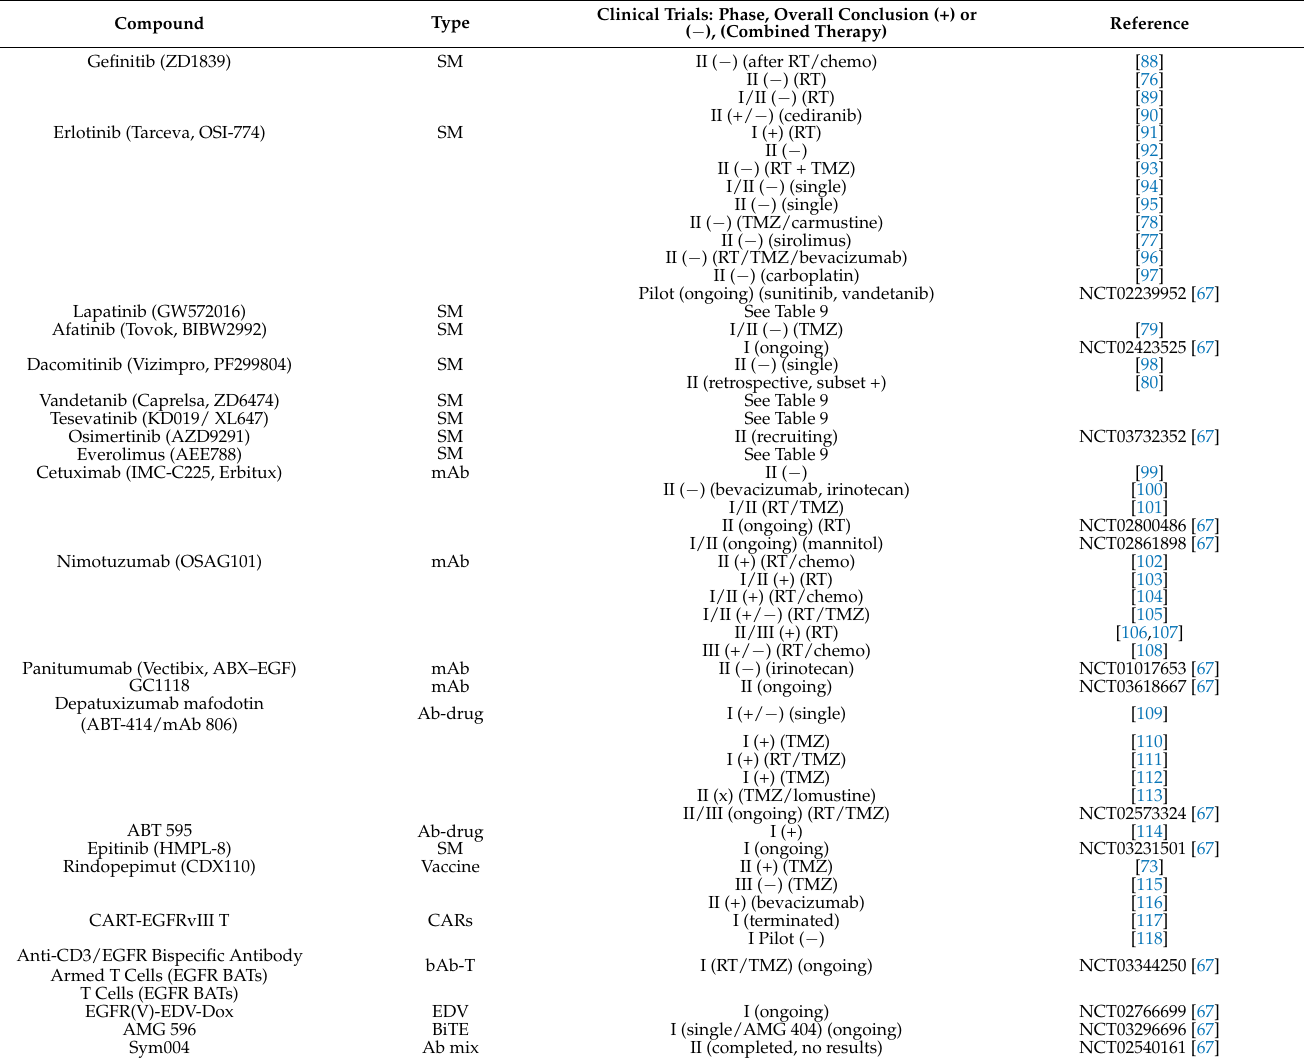
Table 3. Clinical trials in GB targeting the epidermal growth factor